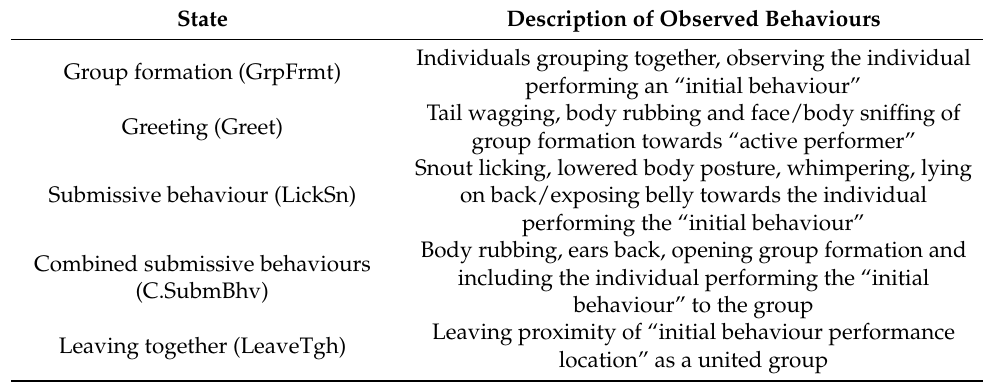
Table 4. Definitions of the social reward behaviour states in a behavioural